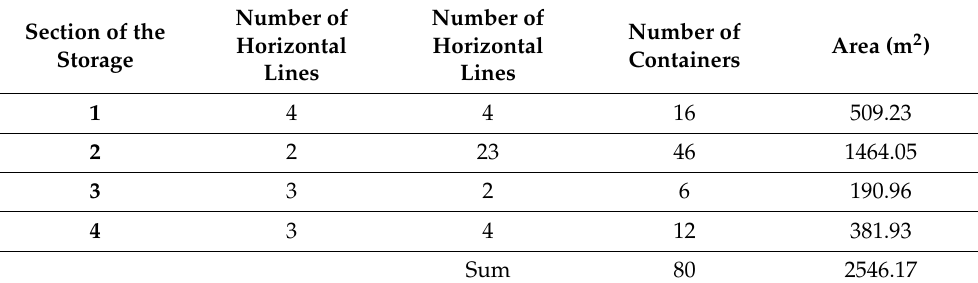
Table 5. Detailed layout storage